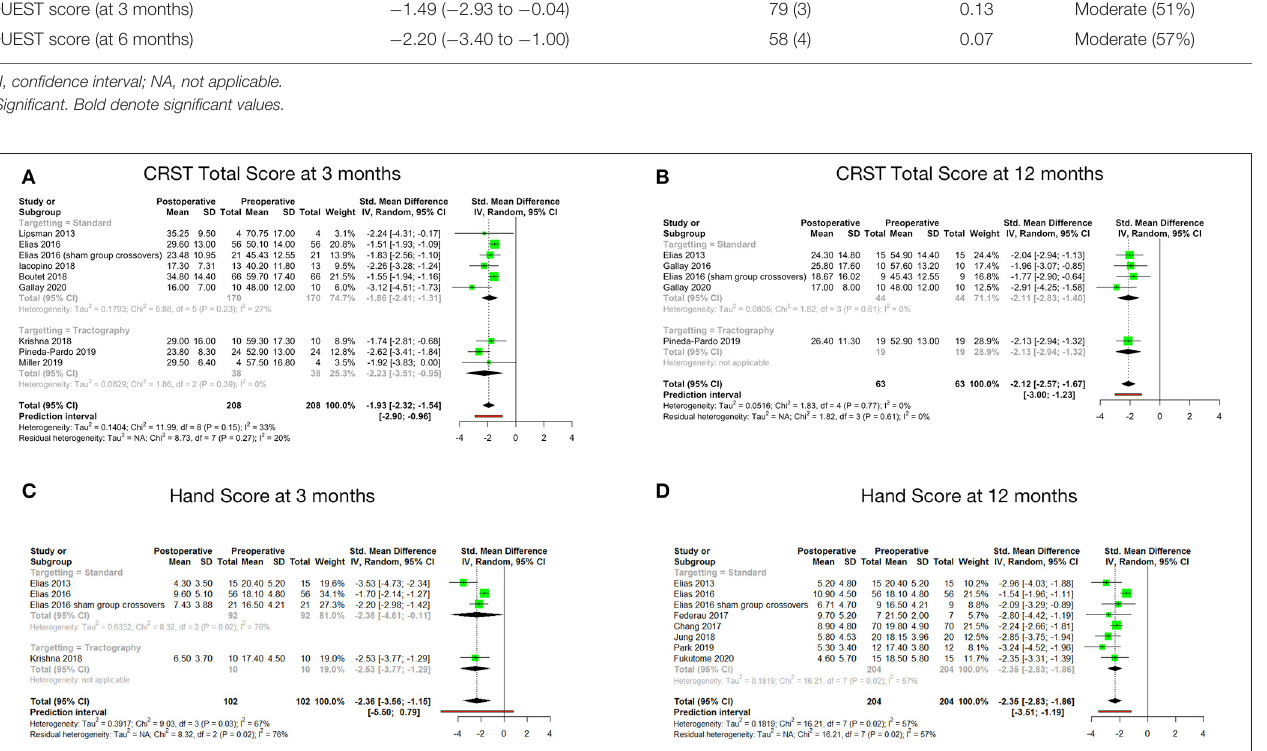
FIGURE 2 | Pooled standard mean difference between preoperative and postoperative total CRST score at 3 months (A) , total CRST score at 12 months (B) , hand score at 3 months (C) and hand score at 12 months (D)